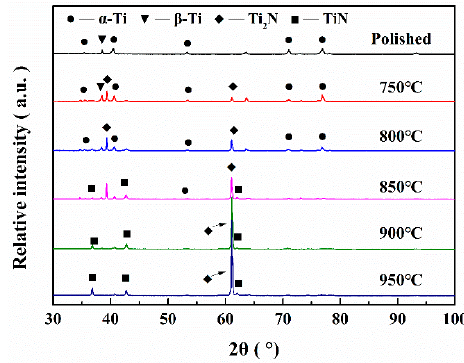
Figure 4. XRD patterns of titanium samples at different nitriding temperatures.